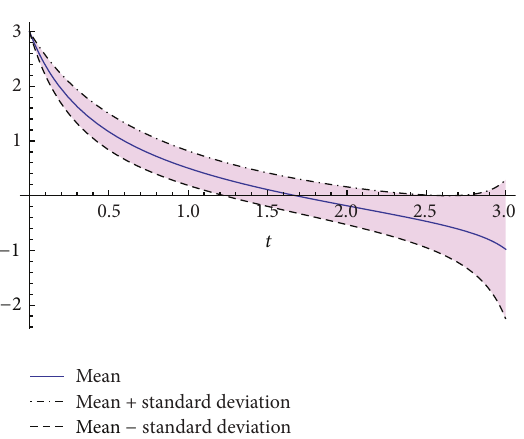
Figure 8: Approximations of the expectation (solid line) and plus/minusstandarddeviation(dashedlines)tothesolutions.p. 𝑦(𝑡) on the interval [0,5] in Example